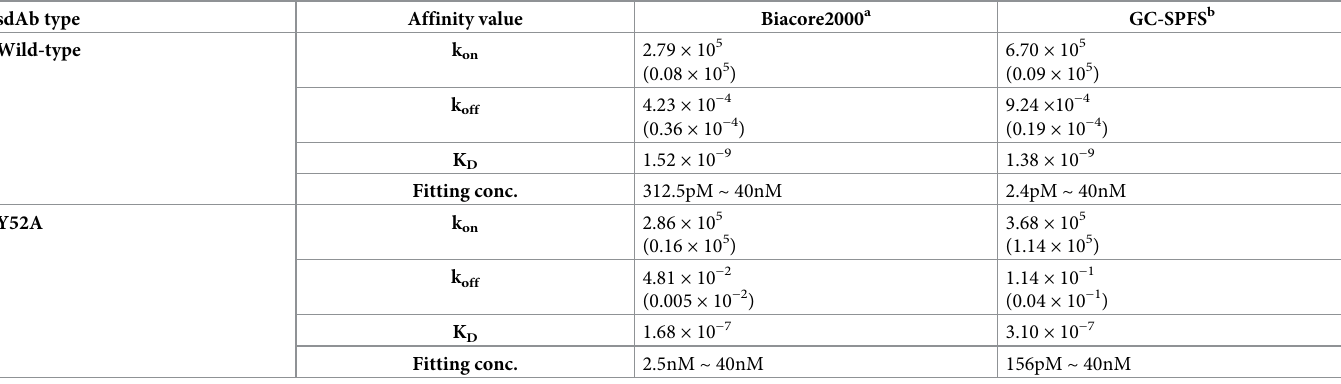
Kinetic affinities (k on , k off , and K D ) of the wild-type anti-lysozyme sdAb and Y52A mutant obtained using the Biacore 2000 and GC-SPFS systems with optical B/F separation. a Biaocre2000 analysis result of a measurement, the brackets indicate standard error. Standard errors of the Biacore software fitting indicated in parentheses. b GC-SPFS analysis result represents the median from three times